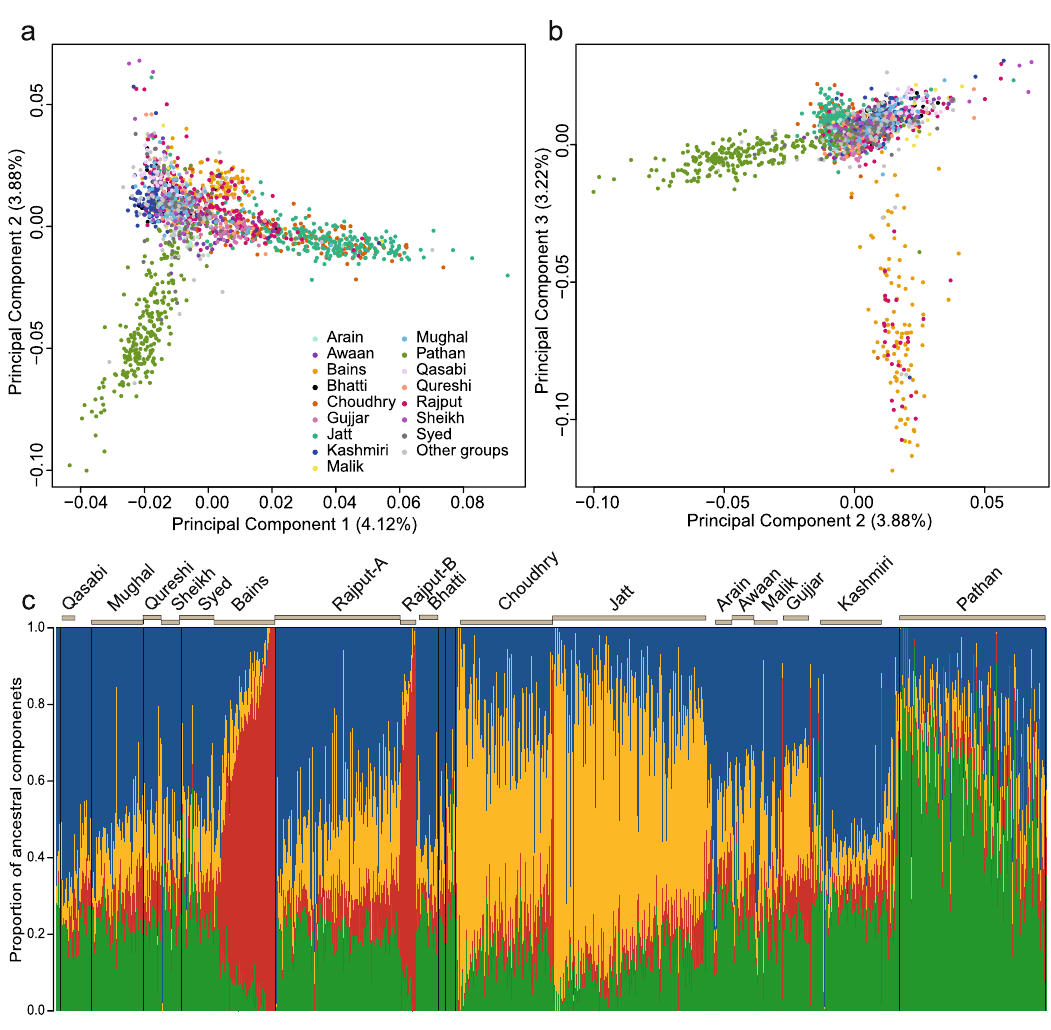
Fig. 1 Population structure within British Pakistanis from Bradford. a , b Principal components analysis of 2200 unrelated Pakistani mothers, with the self- reported subgroups with >20 samples indicated in different colours. Plots show PC1 versus PC2 ( a ) and PC2 versus PC3 ( b ). Proportion of overall variation explained by each PC is noted in brackets on the axis label. c ADMIXTURE plot ( K = 4) illustrating different ancestral components making up the various subgroups, with the largest self-reported subgroups indicated. We have indicated the two distinct subgroups amongst the